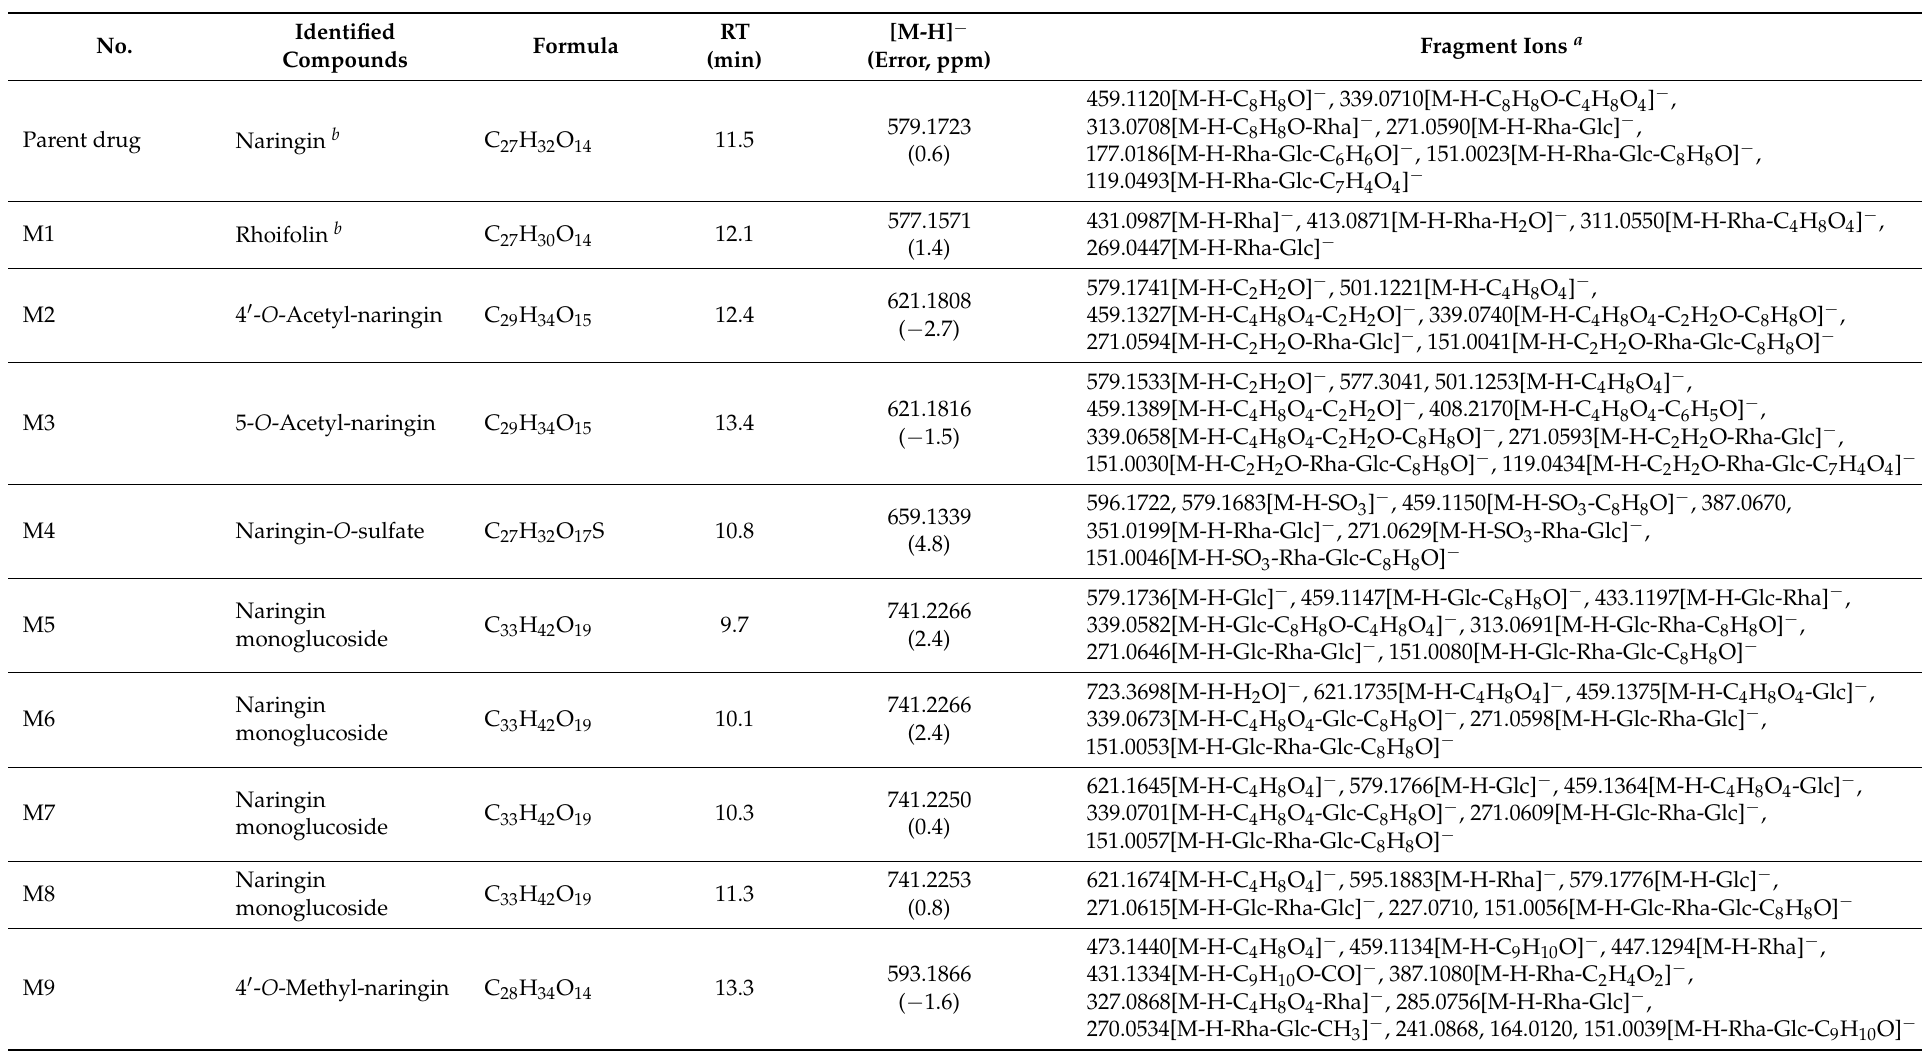
Table 2. UHPLC-Q-TOF-MS/MS-based identification of the microbial metabolites of naringin after in vitro fecal